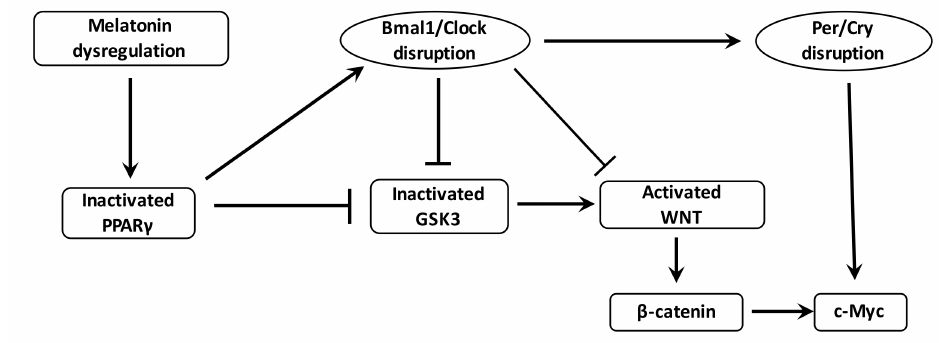
Figure 4. Interactions between PPAR γ , WNT pathway and circadian rhythms in cancer. Dysregulation of melatonin and nocturin decreases the expression of PPAR γ in cancer. Decreased PPAR γ dysregulates the Bmal1 / Clock heterodimer. Decreased PPAR γ expression directly activates the formation of the heterodimer Bmal1 / Clock and β -catenin cytosolic accumulation but inhibits the activity of GSK3, the main inhibitor of the WNT / β -catenin pathway. Bmal1 / Clock knockout also decreases GSK3 activity and activates the WNT / β -catenin pathway and its downstream gene c-Myc through the stimulation of the heterodimer Per / Cry. The activation of the WNT / β -catenin pathway by the cytosolic accumulation of the β -catenin and the activation of c-Myc lead to cancer initiation (oxidative stress and chronic